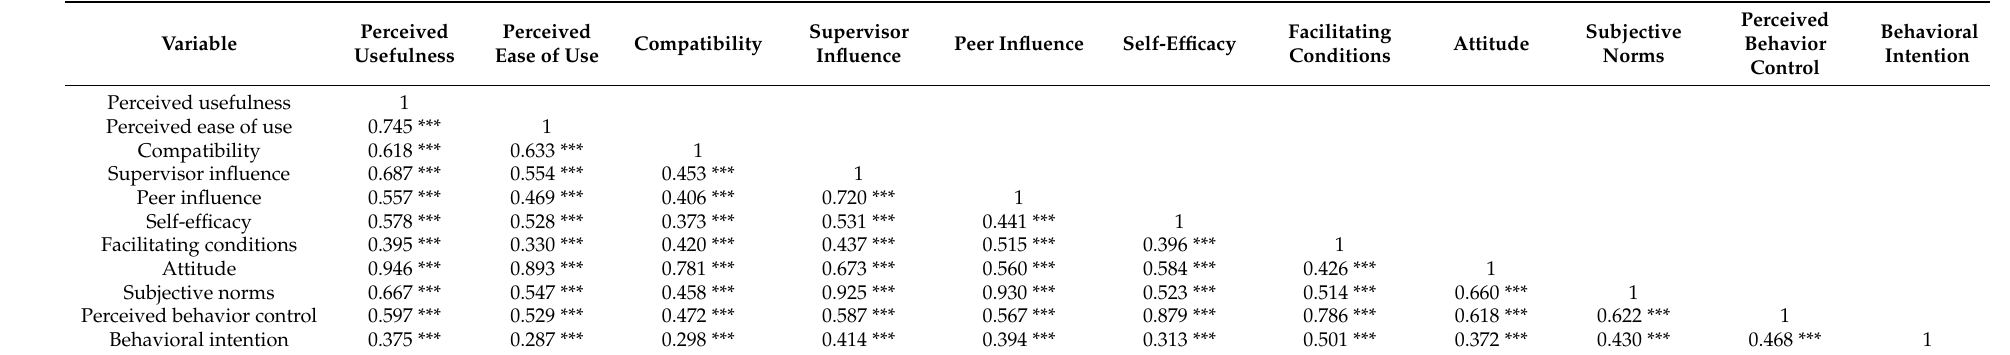
Table 4. Correlation matrix of each variable and behavioral